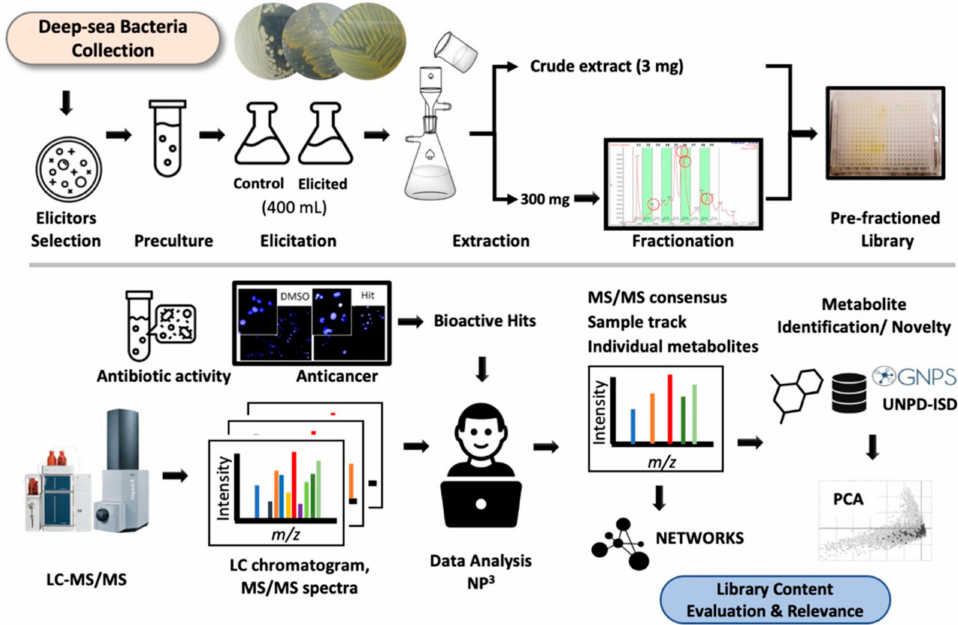
Figure 1. Workflow for the construction (upper panel) and analysis (bottom panel) of the elicited pre-fractionated bacterial EPfB chemical library discussed in the present